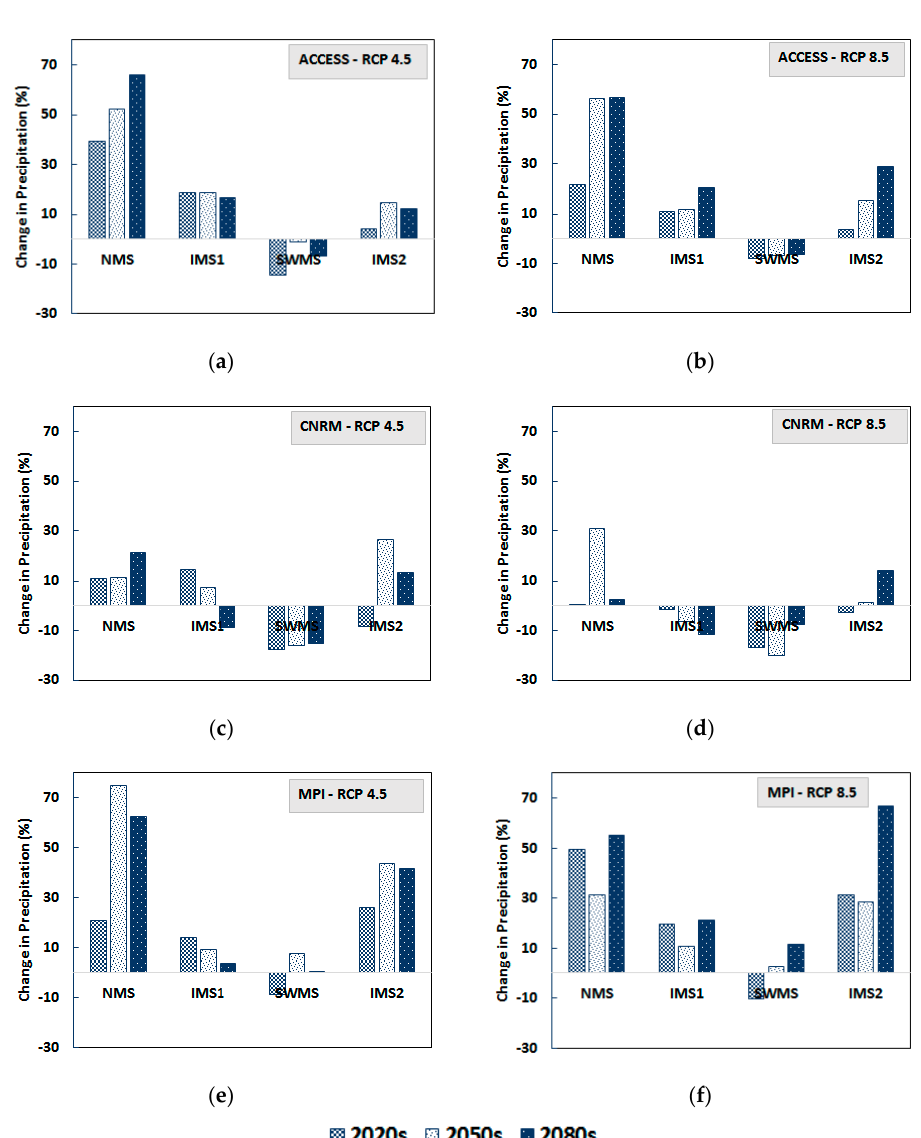
Figure 5. Seasonal change in precipitation in different periods for three RCMs ACCESS, CNRM and MPI under RCP4.5 and RCP8.5 in Nilwala watershed. ( a ) For ACCESS-RCP4.5, ( b ) for ACCESS-RCP8.5, ( c ) for CNRM-RCP4.5, ( d ) for CNRM-RCP8.5, ( e ) for MPI-RCP4.5, and ( f ) for MPI-RCP8.5.